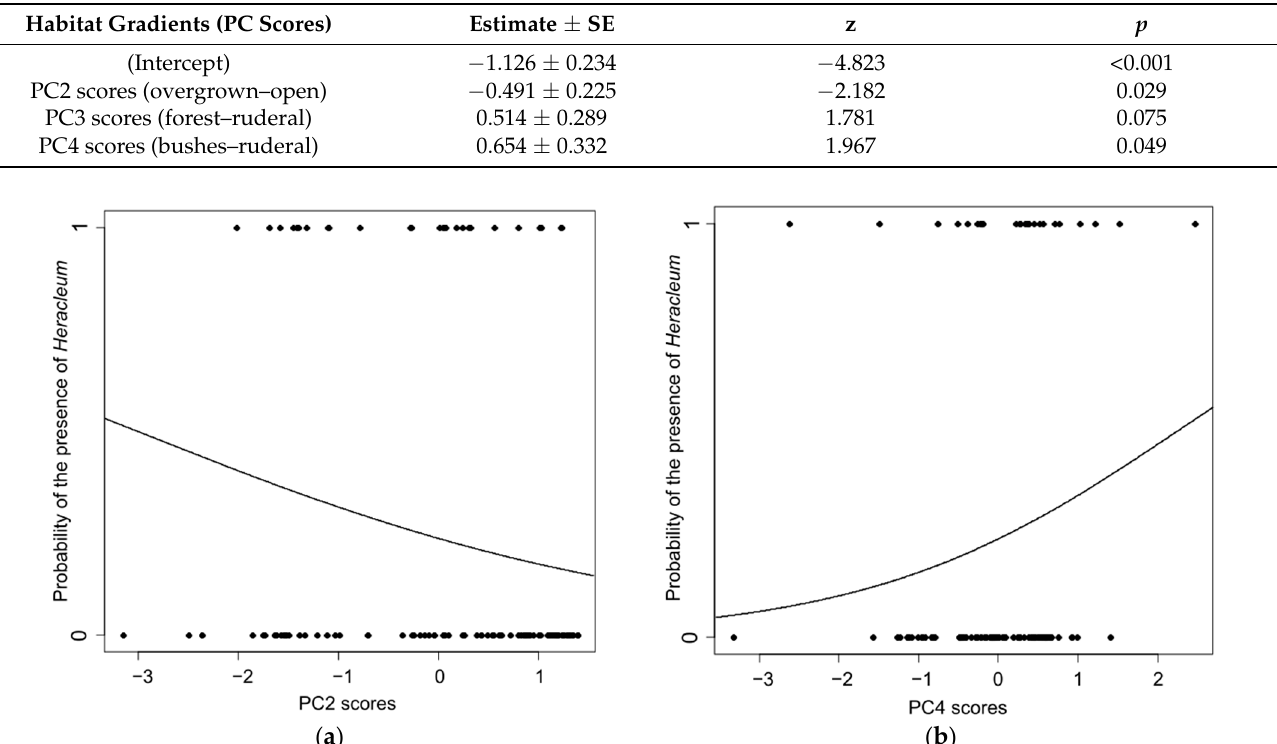
Figure 7. The probability of the presence of Caucasian hogweeds higher with increasing overgrown areas and decreasing open areas ( a ); and a higher probability of the invaders’ presence in the in- creasing ruderal areas along with a decrease in bushes ( b